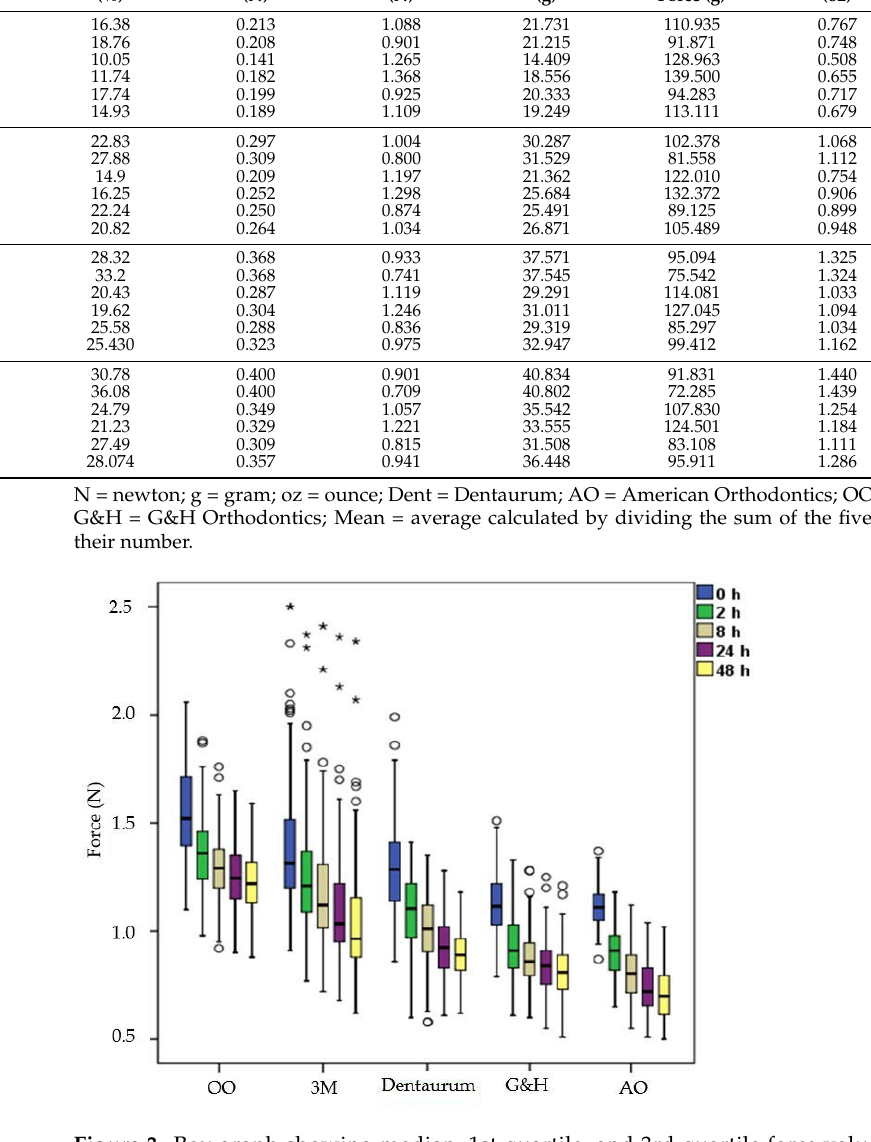
Figure 3. Box graph showing median, 1st quartile, and 3rd quartile force values for all five man- ufacturers measured at all time periods; ◦ = outliers; * = extreme values; h = hours; N = newton. Figure 1. ( a ) The optimal controls of three players for the system with linear dynamics with case of AO = American Orthodontics; OO = Ortho Organizers; G&H = G&H uncertainty 1. ( b ) The optimal trajectories of three players for the system with linear dynamics with case of uncertainty 1.